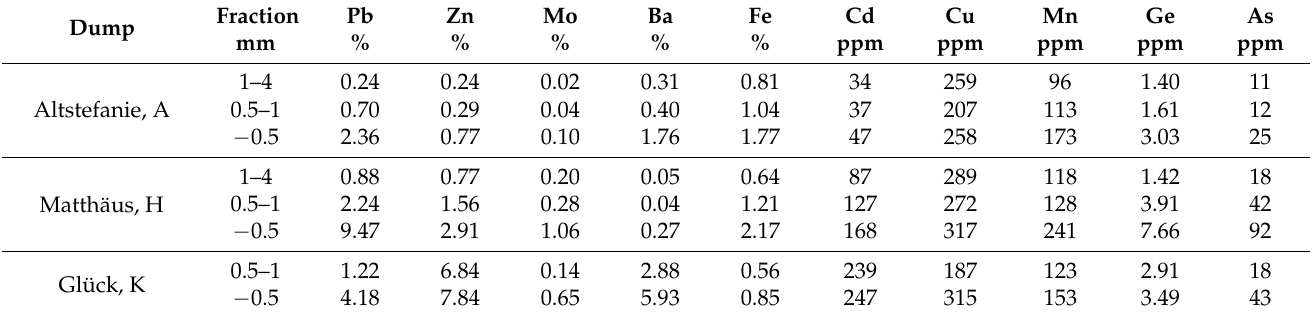
Table 4. Partial results of analyses of the “pre-sampling”. Data for “Glück” 1–4 mm is not